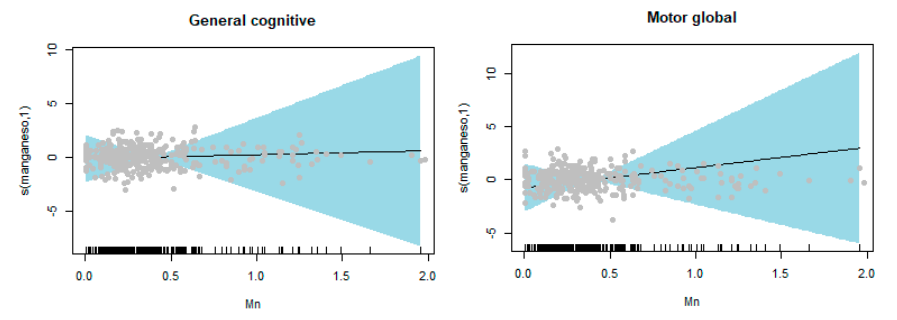
Figure 2. Generalized additive models for the general cognitive and general motor scales.